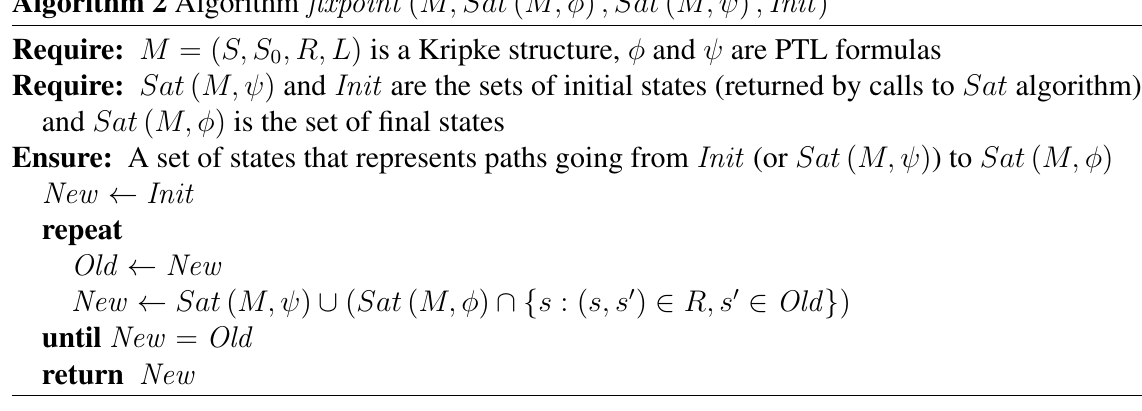
Algorithm 2 Algorithm fixpoint ( M, Sat ( M, φ ) , Sat ( M, ψ ) , Init